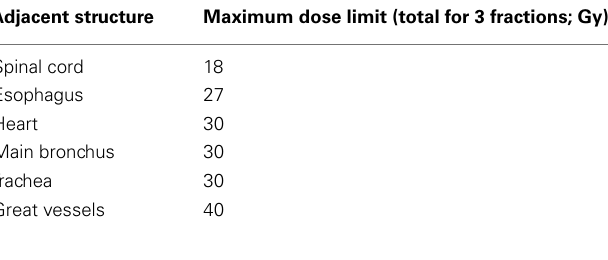
Table 1 | Critical central structure radiation point dose limits. Adjacent